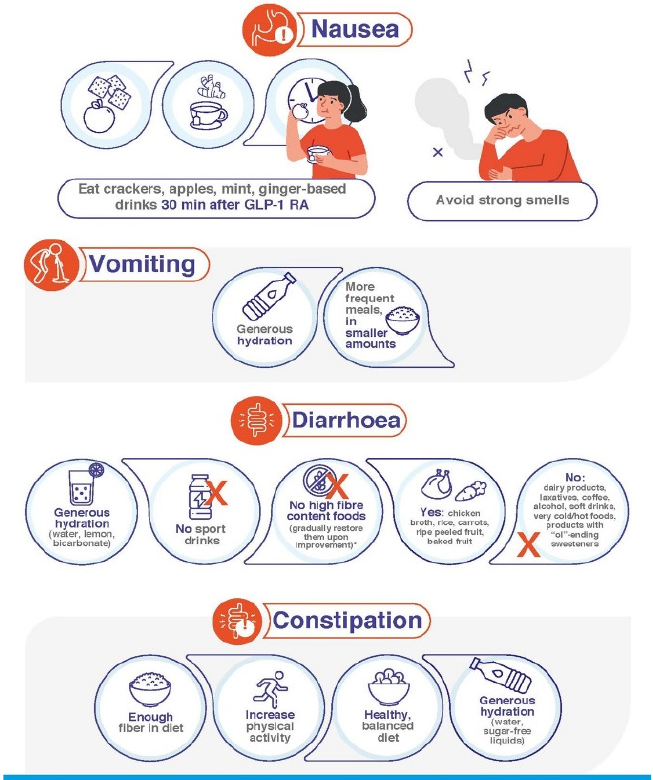
Figure 2. Additional specific guidelines for each separate GI AE.